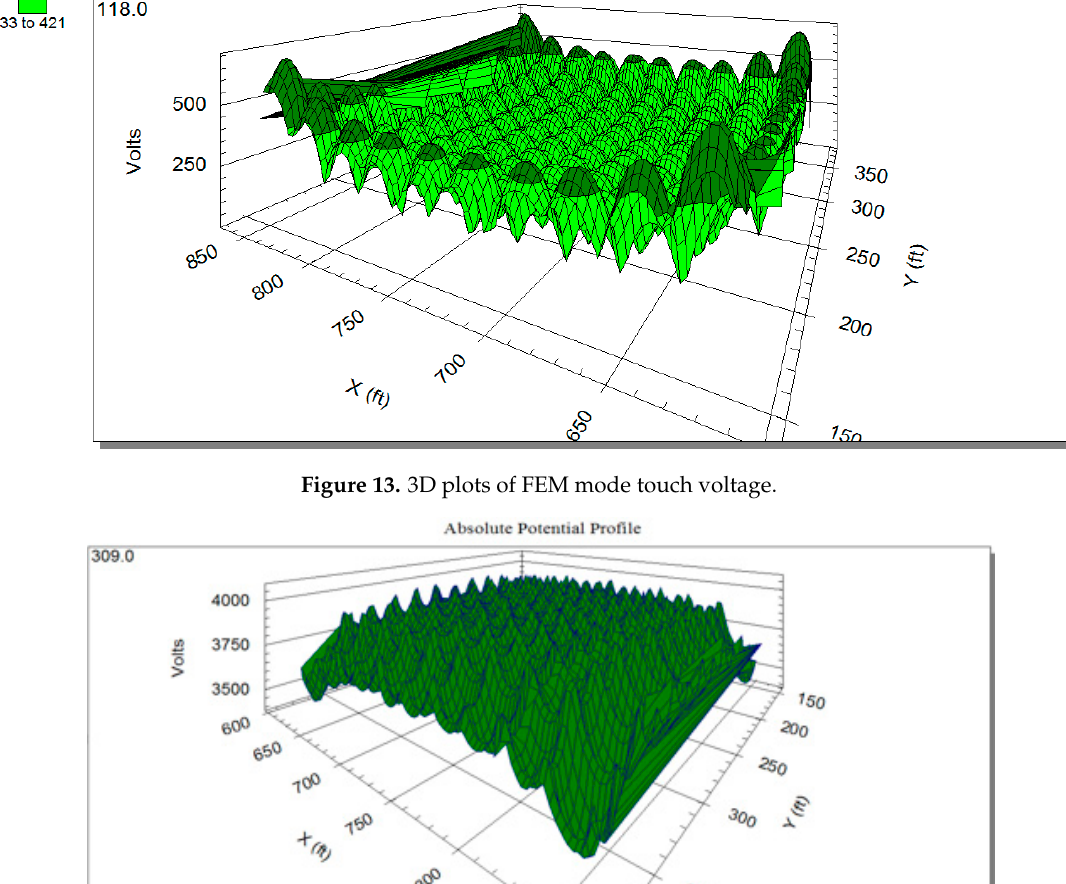
Figure 14. 3D plots of FEM mode absolute voltage.